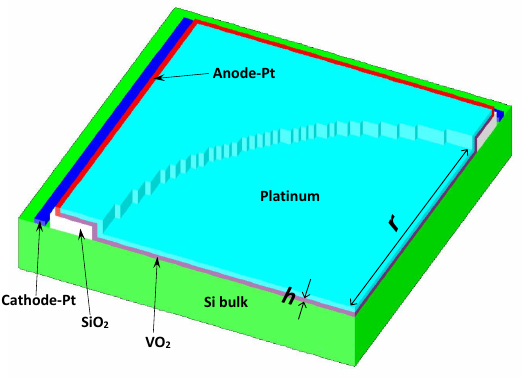
Figure 7. SUNRED model for VO 2 vertical